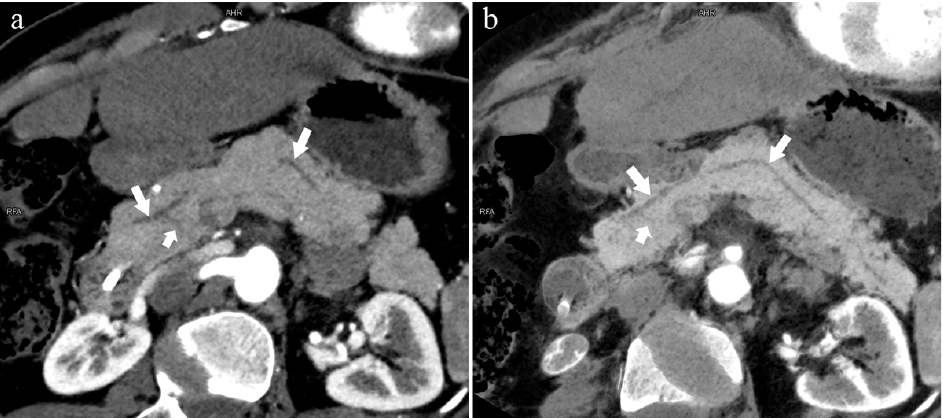
Figure 9. Type 3a. A 49-year-old male patient with IPMN. ( a ): MIP [45 keV MEI (+)] shows the enlarged head of the pancreas with tumor (pentagram), and tortuous dilation of MPD (long arrow) and APD (short arrow). The APD communicates with the front segment of the MPD without flowing into the MiP. The drainage tube (arrow) can be seen in the MPD. ( b ): MinIP [45 keV MEI (+)] reduces the interference of ductal artifacts and shows the course and more detail of the distal pancreatic duct. Postoperative pathology confirmed that the mass was IPMN.